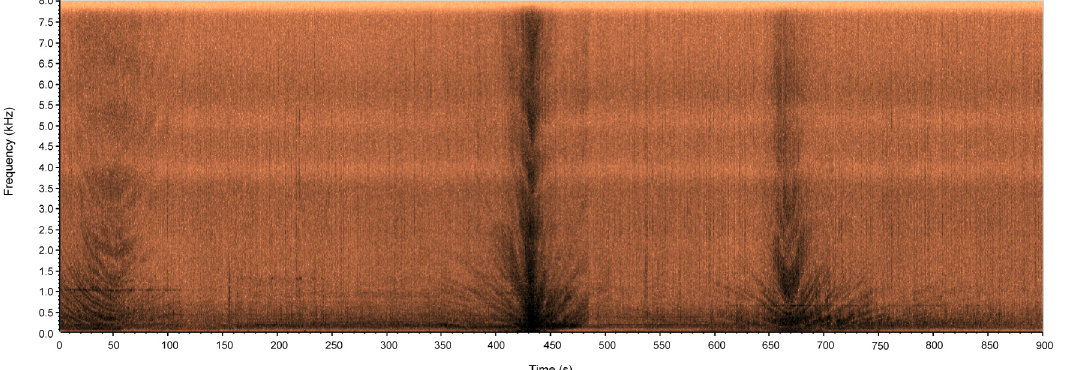
Fig 9. Spectrogram depicting marine traffic near the city of Santos, SP,